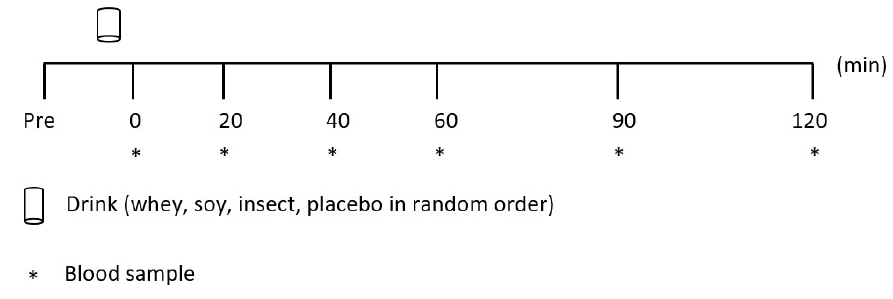
Figure 1. Experimental protocol.